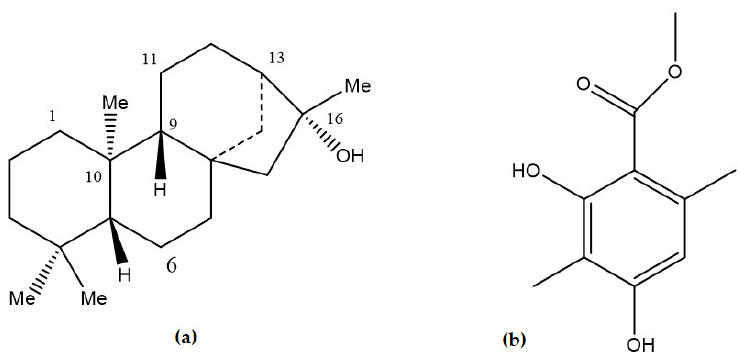
Figure 3. Chemical structure of ( a ) ( − )-ent-Kauran-16a-ol and ( b ) Atraric acid.